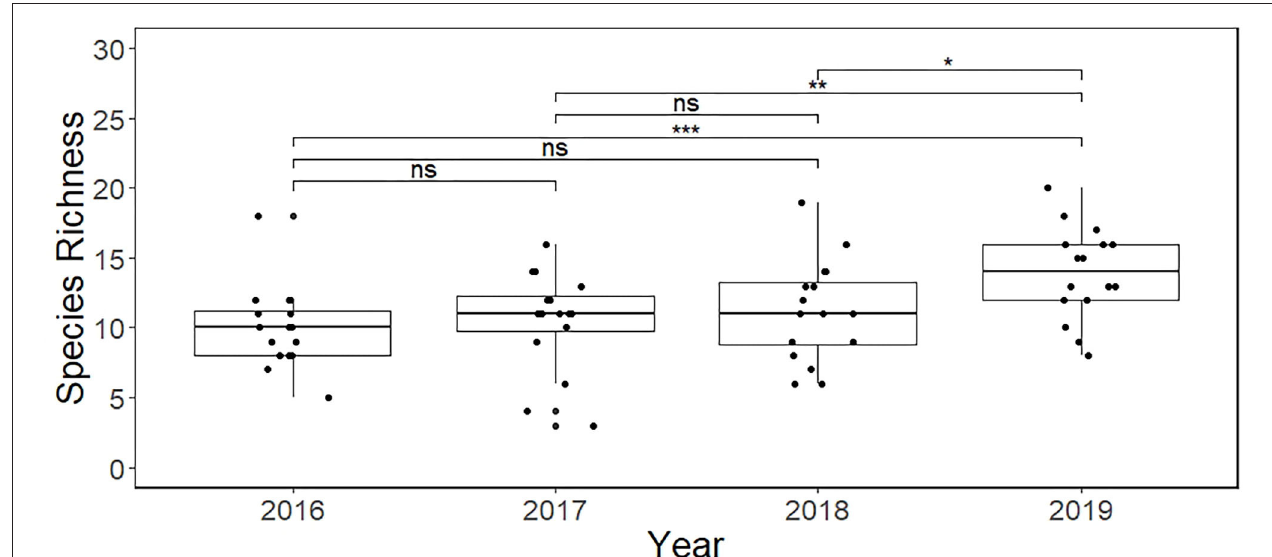
FIGURE 4 | Species richness (SR) detected over four consecutive years from the 16 camera sites retained on the wildlife-friendly farm. The median value, interquartile range and range are shown for each year. The letters above each plot indicate significant differences (ns-not significant, *’s indicate the degree of